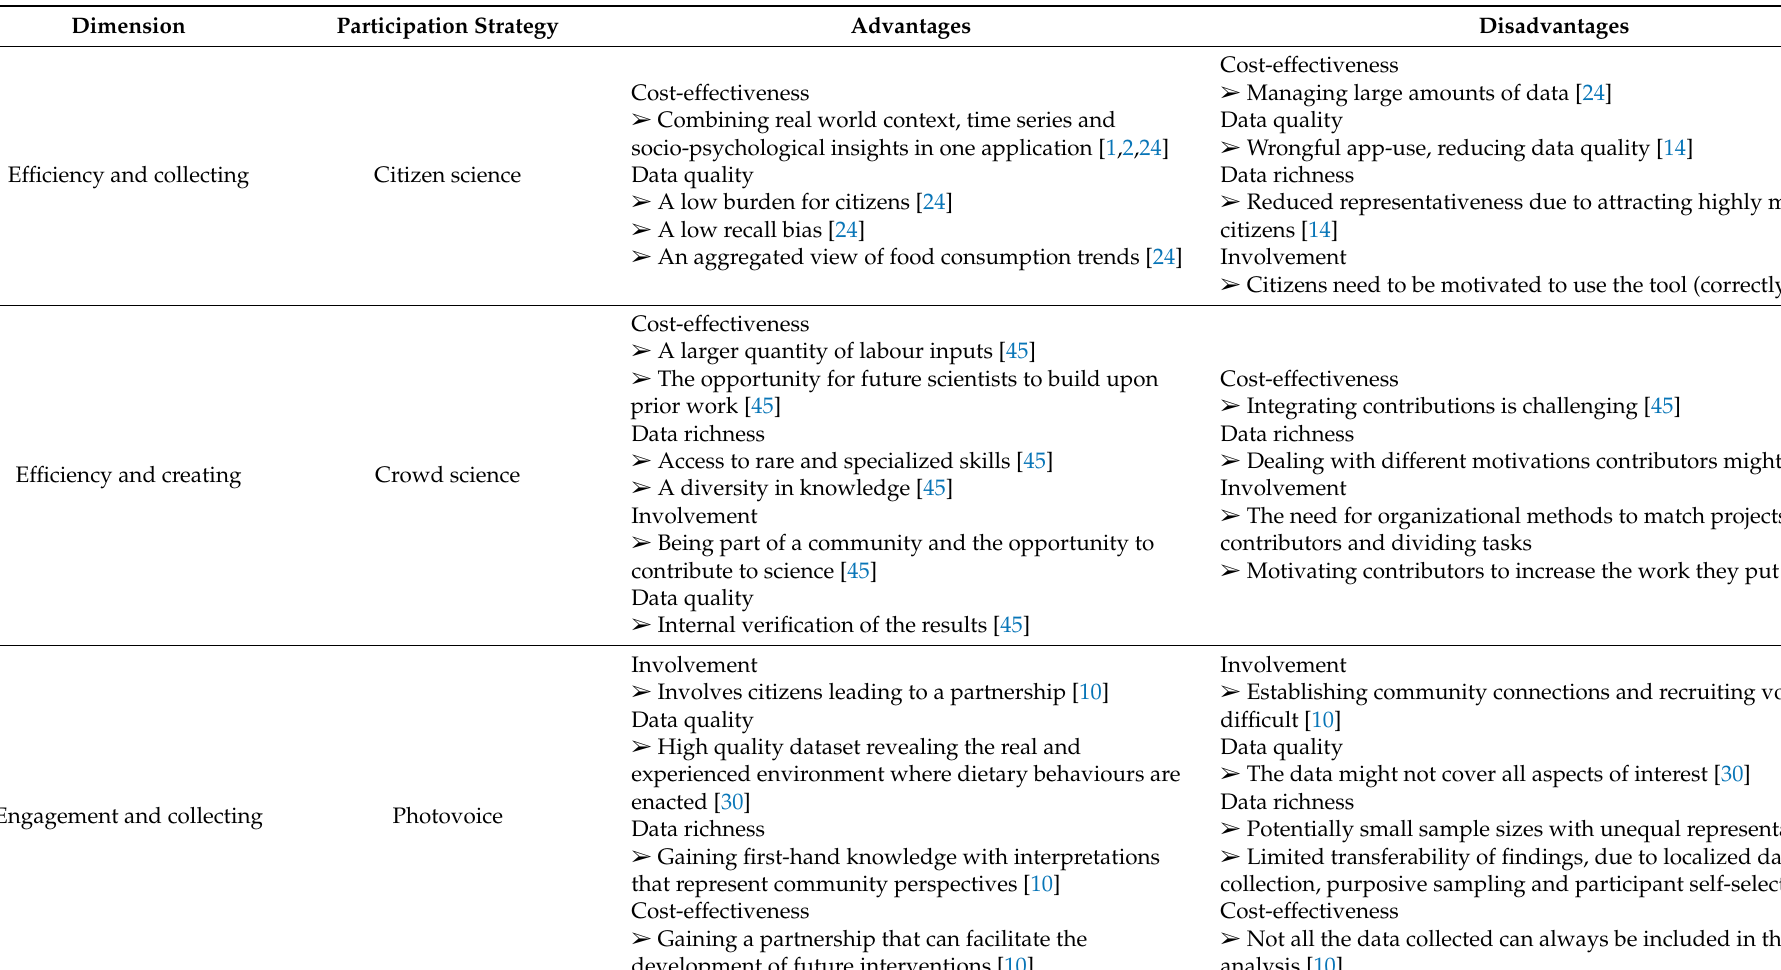
Table A1. Overview of the Advantages and Disadvantages of Using Participation in Food Behaviour